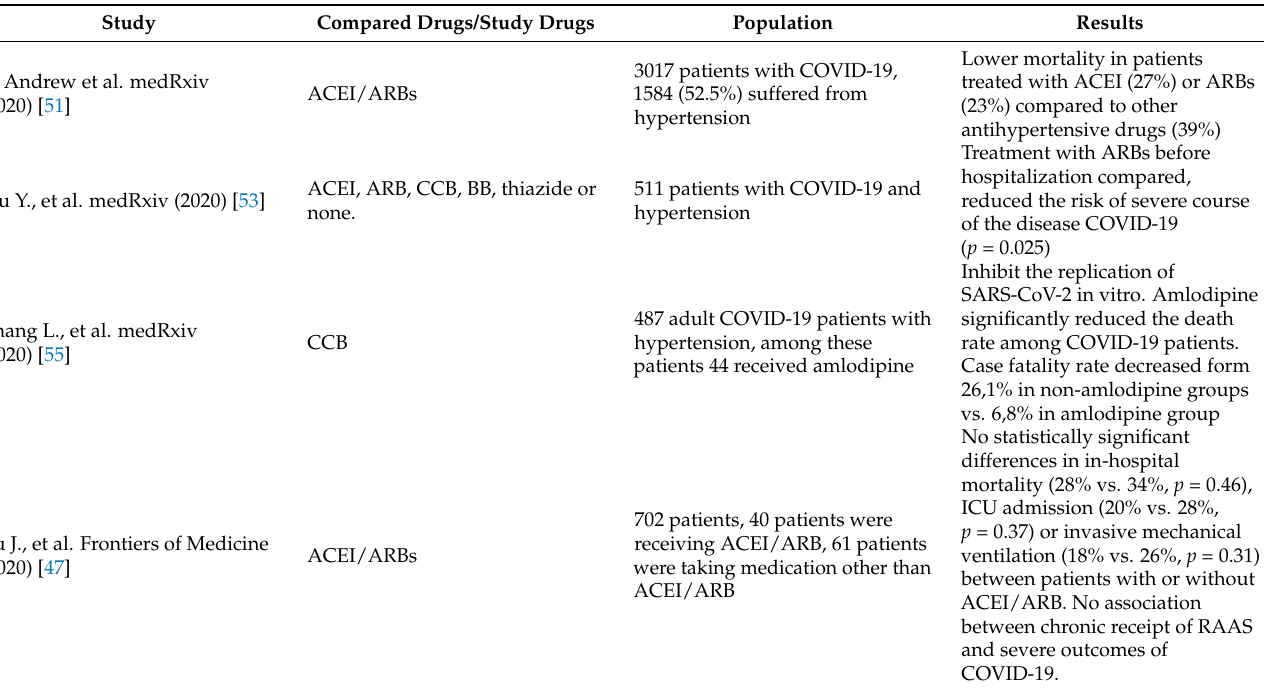
Table 1. Studies on antihypertensive treatment in